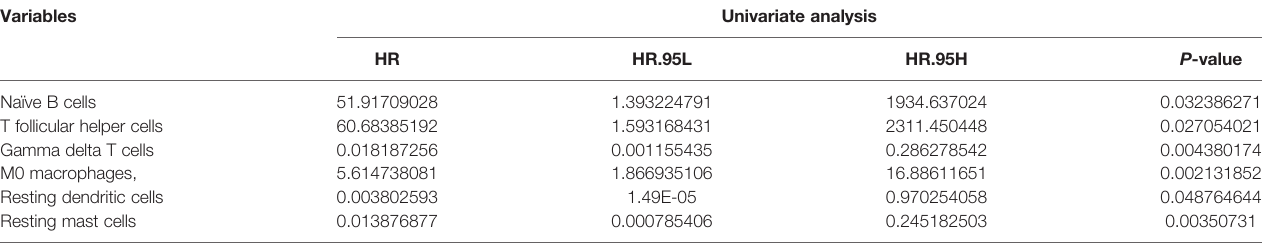
TABLE 1 | Univariate analysis showing associations between different immune cell subsets and OS in BRCA. Unadjusted HRs are shown with 95 percent con fi dence intervals.